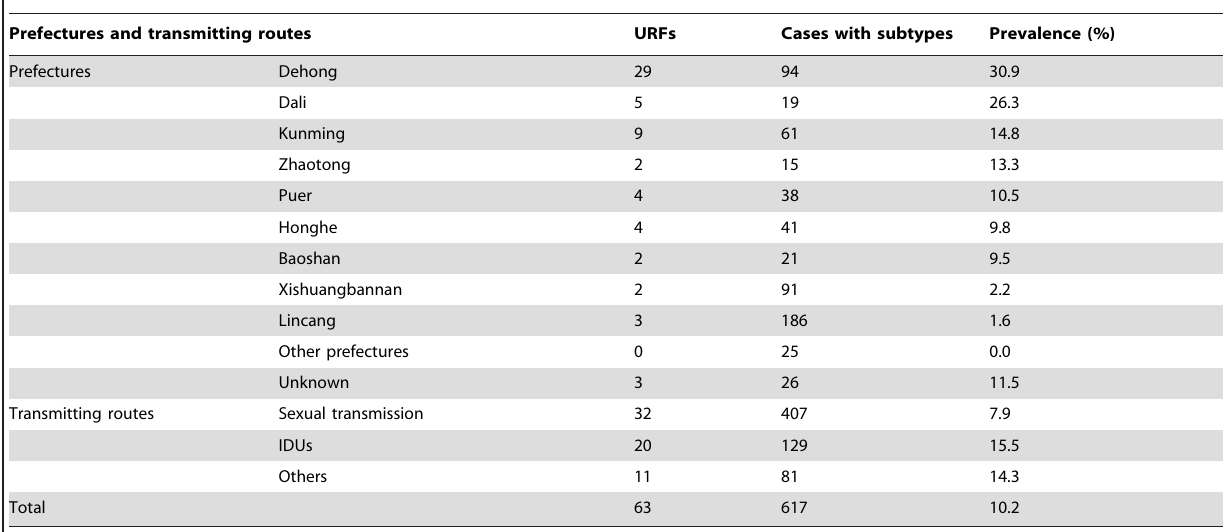
Table 1. Distribution of URFs in different prefectures and transmitting routes in Yunnan.